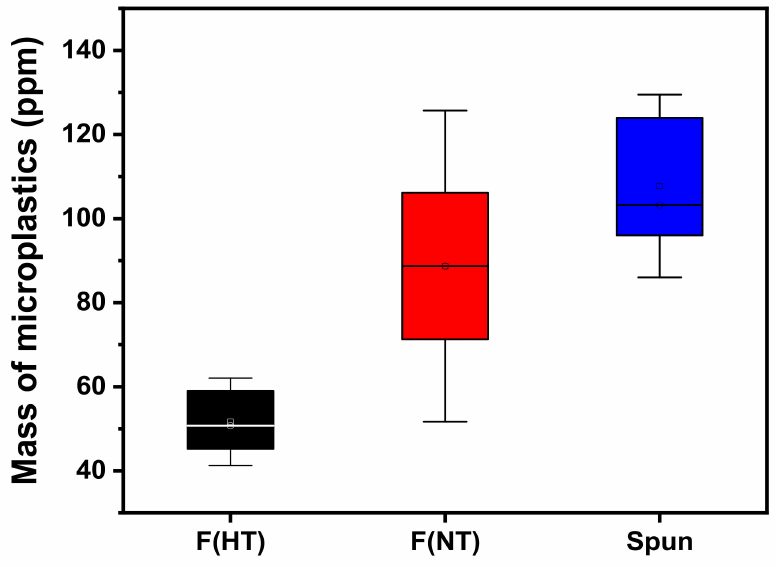
Figure 3. Amount of microplastics according to yarn types during